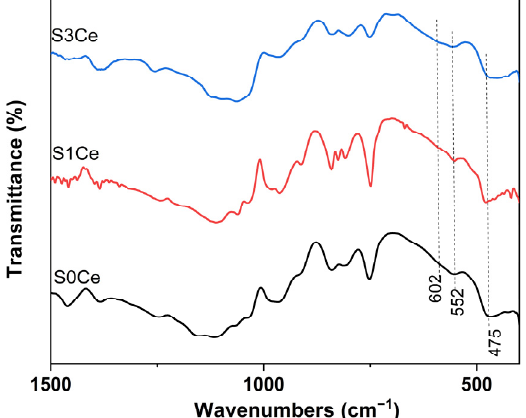
Figure 8. FTIR spectra of the PMMA-MBGs composite scaffolds immersed for five days in SBF solution.